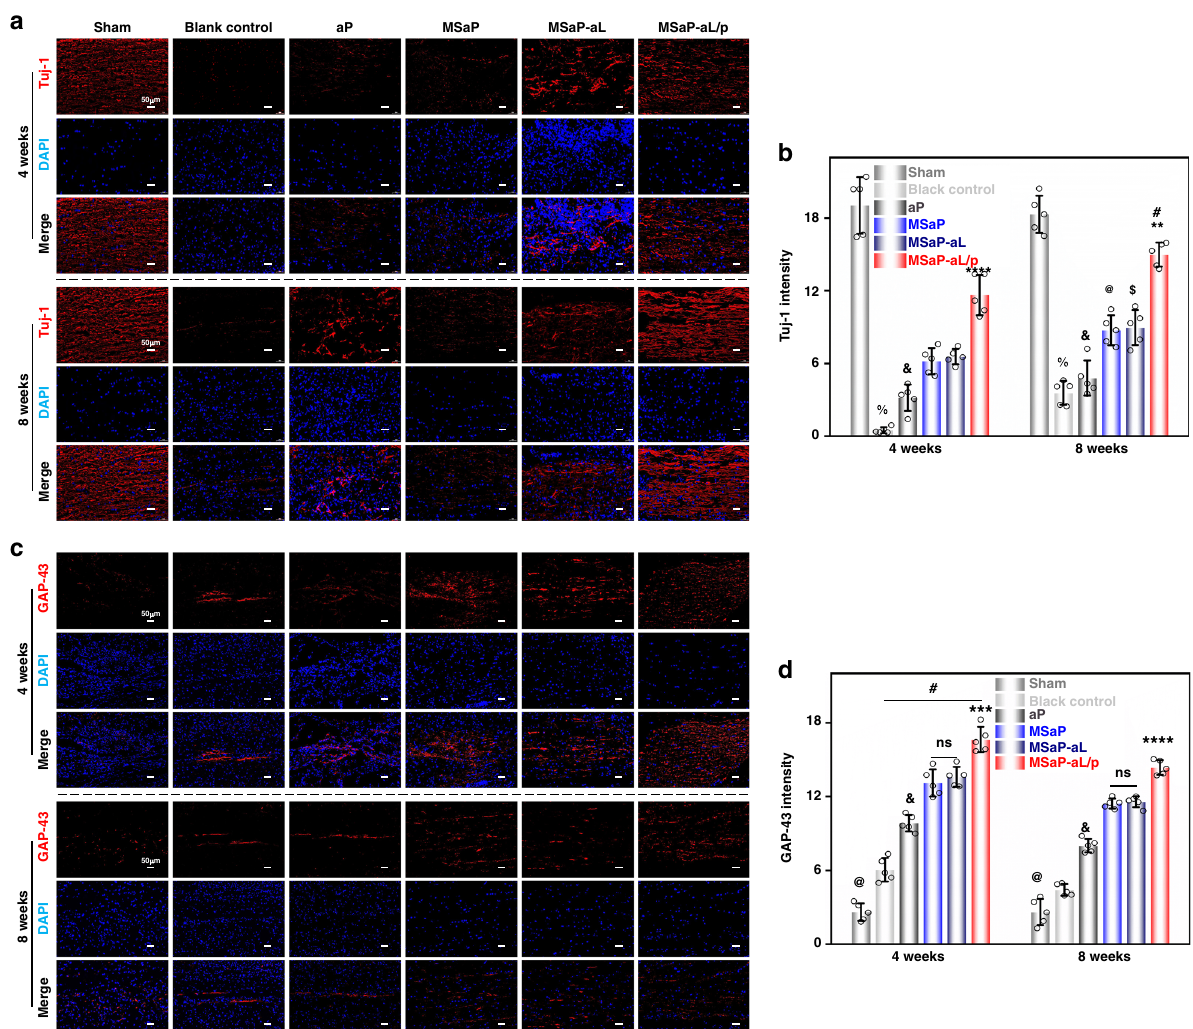
Fig. 11 Immuno fl uorescence staining of neuron cells and axons. a Immuno fl uorescence staining of neuron cells (scale bars are 50 µ m, 3 independent experiments) and b quanti fi cation analyzed with optical density ( n = 5, Tuj-1 intensity values were mean ± std. dev., % p < 0.0001 when comparing blank control and microsol electrospun groups (MSaP, MSaP-aL, and MSaP-aL/p); & p < 0.05 when comparing aP and microsol electrospun groups (MSaP, MSaP-aL, and MSaP-aL/p); @ p < 0.01 when comparing 4w and 8w in MSaP; $ p < 0.01 when comparing 4w and 8w in MSaP-aL and # p < 0.01 when comparing 4w and 8w in MSaP-aL/p; ** p < 0.01, **** p < 0.0001 when comparing MSaP-aL/p and other control groups at the same time point via two-way analysis of variance (ANOVA) with Tukey ’ s post hoc test). c Immuno fl uorescence staining of axon (scale bars were 50 µ m, 3 independent experiments) with d its quanti fi cation analyzed with optical density ( n = 5, GAP-43 intensity values were mean ± std. dev., # p < 0.05 when comparing 4w and 8w in blank control, aP, MSaP, MSaP-aL, and MSaP-aL/p, respectively; @ p < 0.01 when comparing sham group and other groups, & p < 0.0001 when comparing aP and microsol electrospun groups (MSaP, MSaP-aL, and MSaP-aL/p), and *** p < 0.001, **** p < 0.0001 when comparing MSaP-aL/p and other control groups at the same time point via two-way analysis of variance (ANOVA) with Tukey ’ s post hoc